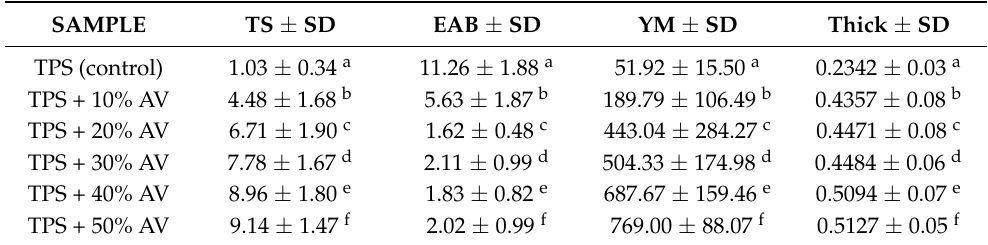
Table 1. The tensile strength, elongation at break, Young’s modulus, and thickness of TPS film at different concentrations of AV